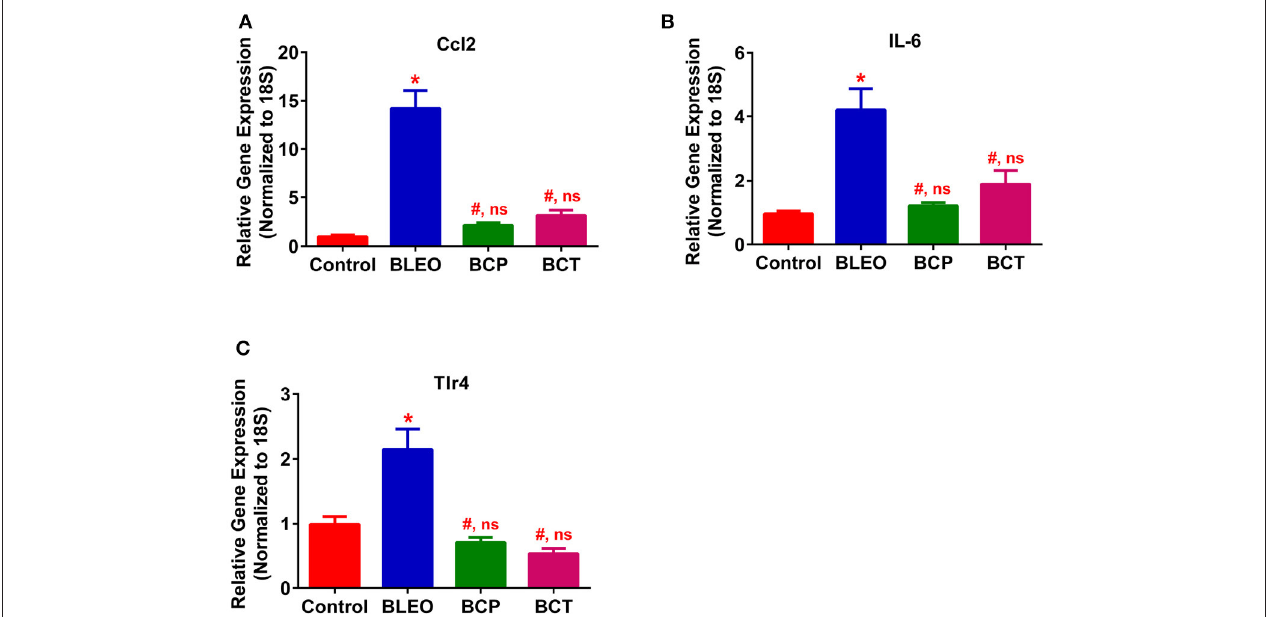
FIGURE 6 | C21 treatment attenuates the expression of inflammatory markers in BLEO animals (A) Ccl2, (B) IL-6, and (C) Tlr4. Data represented in (A–C) are mean ± SEM, n = 5 animals/group. *Indicates a p -value of ≤ 0.05, comparing BLEO animals against the controls. # Indicates a p -value of ≤ 0.05, comparing BCP and BCT vs. BLEO. ns indicates a p -value of non-significant, comparing BCP and BCT vs. control.